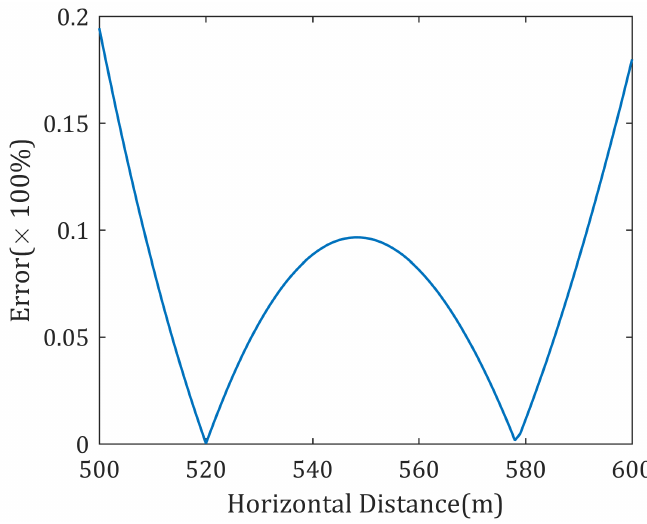
Figure 4. Approximation error of ground-to-air uplink channel in a small-scale